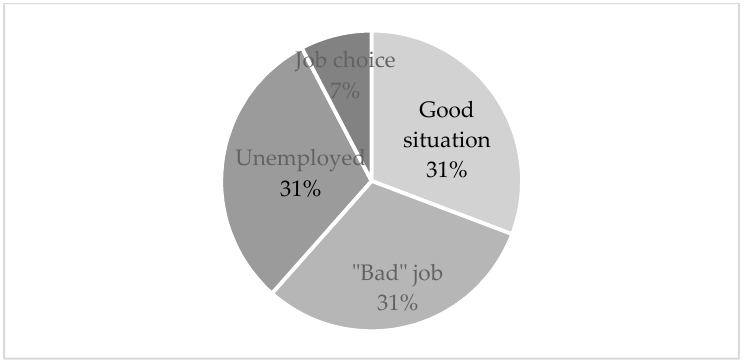
Figure 1. Chart showing employment before moving to an eco-community. Source: Prepared by the authors.